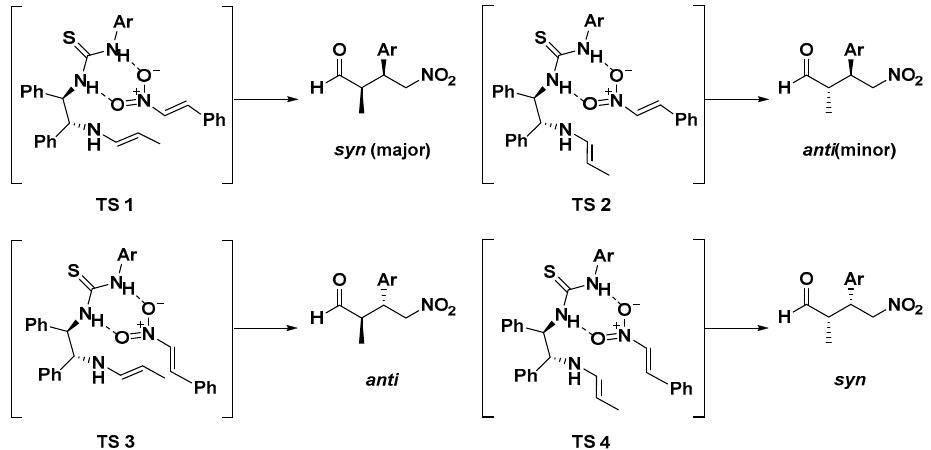
Figure 3. Possible stereochemical transition state models and expected syn and anti products. This figure shows the reaction mechanism proposed for the Michael reaction presented below.